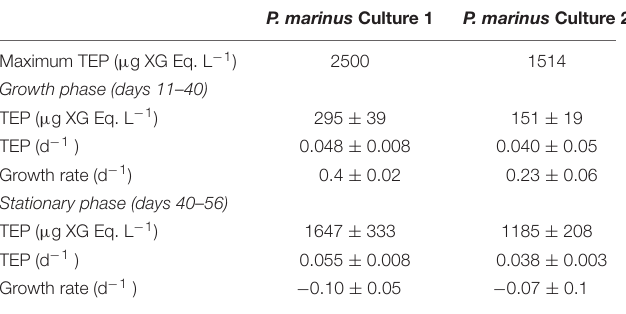
TABLE 2 | Growth rate (d − 1 , mean ± SE), maximum and mean ( ± SE) concentration and specific production rates (d − 1 , mean ± SE) of transparent exopolymer particles (TEP) observed in cultures of Prochlorococcus marinus